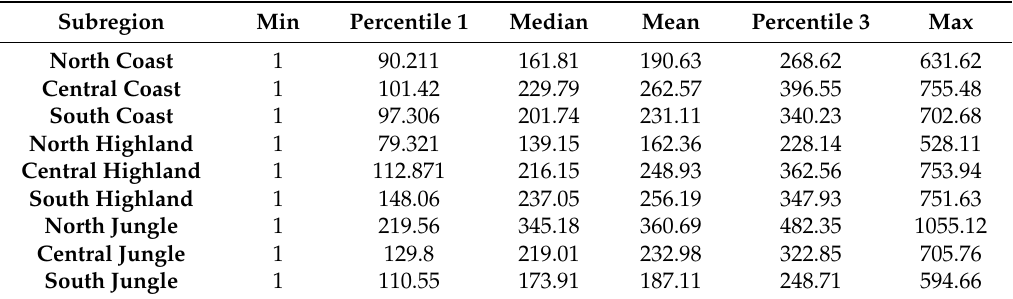
Table 2. Statistical analysis of distances (in km) for the sub-regions of the study area. Values correspond to the minimum (min), percentile 1, median, average distance (mean), percentile 3 and maximum (max) Euclidean distance. Values extracted from MODIS